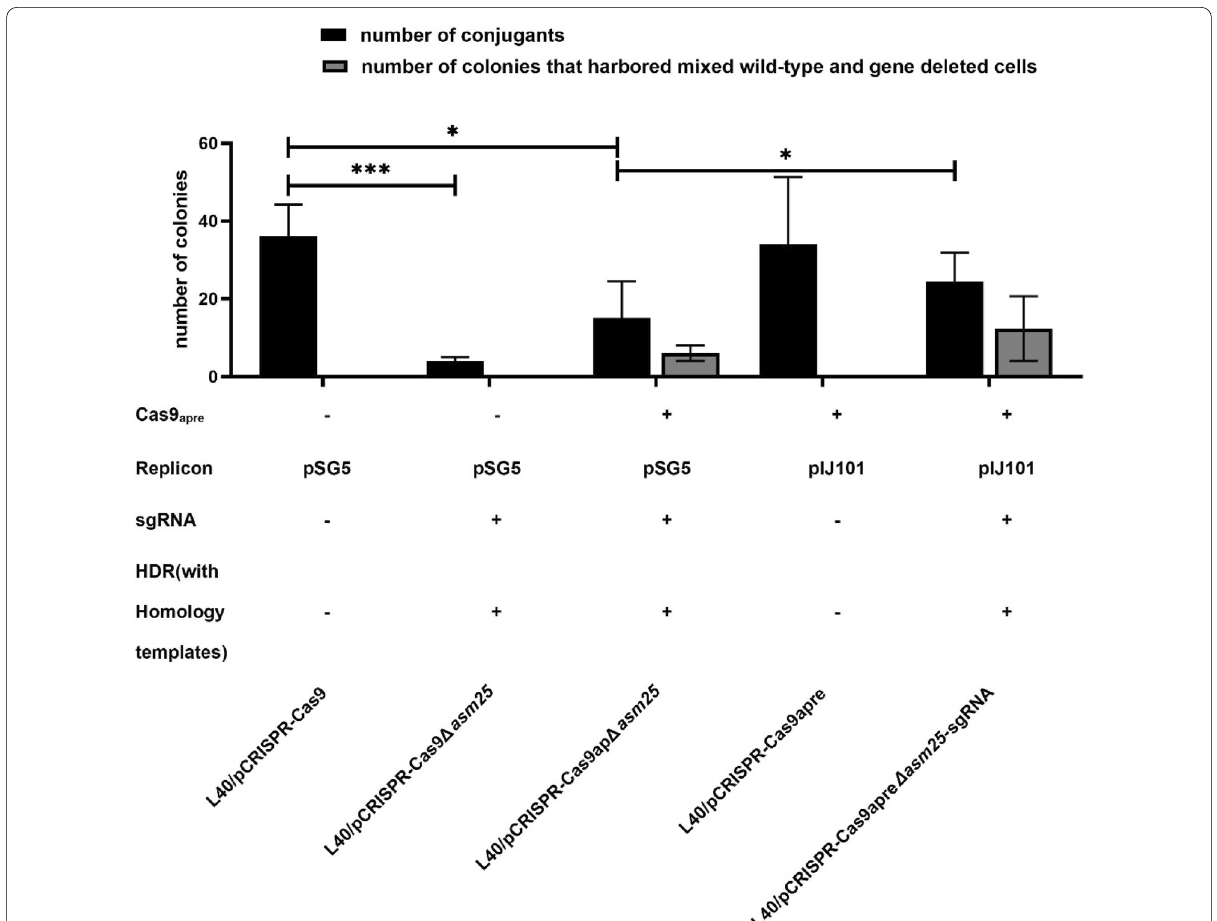
Fig. 2 Conjugation transfer efficiency of optimized CRISPR–Cas9 plasmids. Data are means conjugations. The total colonies were counted directly. Significant differences were analyzed by two-way ANOVA, and * p < 0.05, *** p <